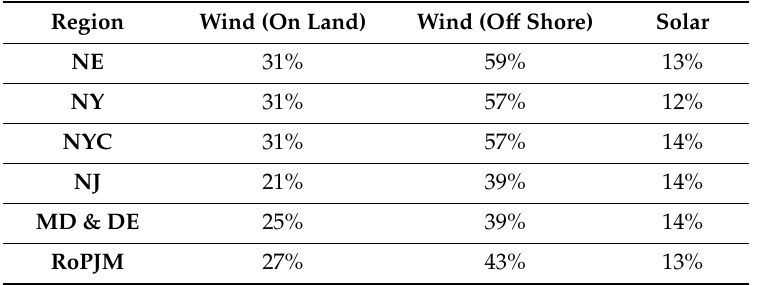
TableA4. UnitCapacityFactorsbyRegion(CambridgeEnergySolutions, 2011)(U.S.EnergyInformation Administration,